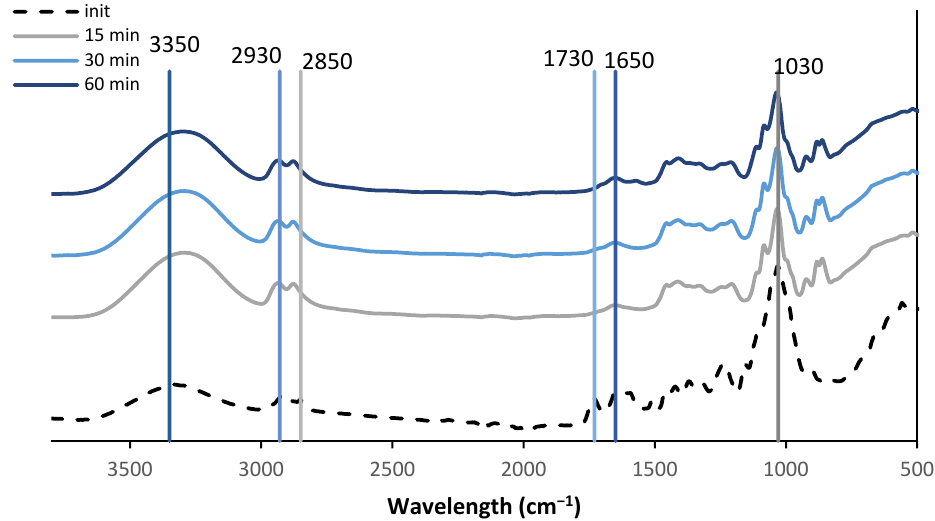
Figure 5. FTIR spectra of the initial material and the liquefied polyol at 180 °C for 15 min, 30 min and 60 min at 180 °C with acid catalysis.